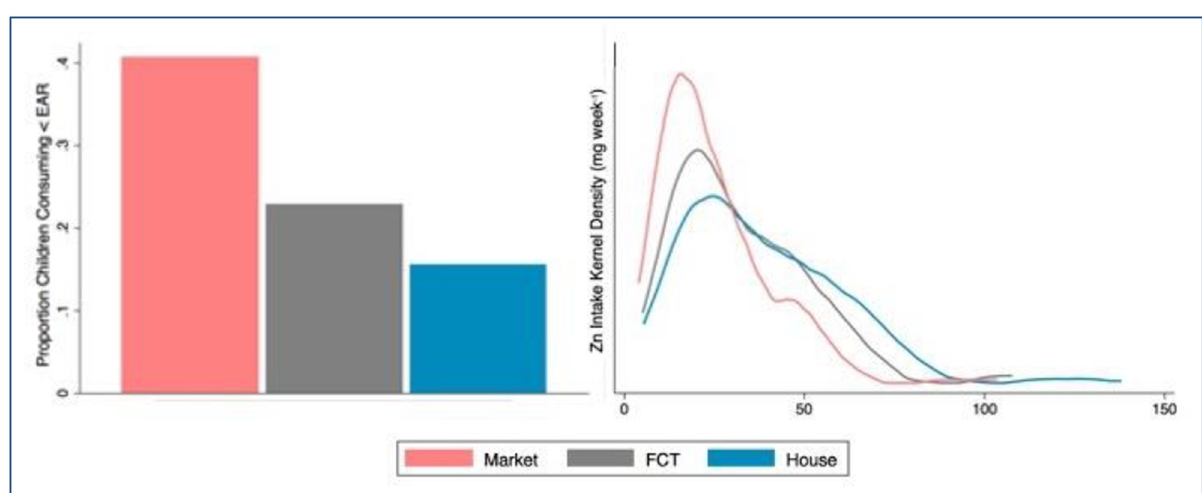
Fig 6. Prevalence of inadequate dietary Zn intake. Left: Proportion of children whose estimated dietary Zn intake is inadequate (mg day -1 < EAR). Right: Kernel density distributions for estimated weekly Zn intake. For both graphics, “Market” denotes Zn concentrations measured in samples collected from markets, “FCT” denotes staple Zn concentrations reported in the HarvestPlus food composition table, and “House” denotes Zn concentrations measured in samples collected from households.